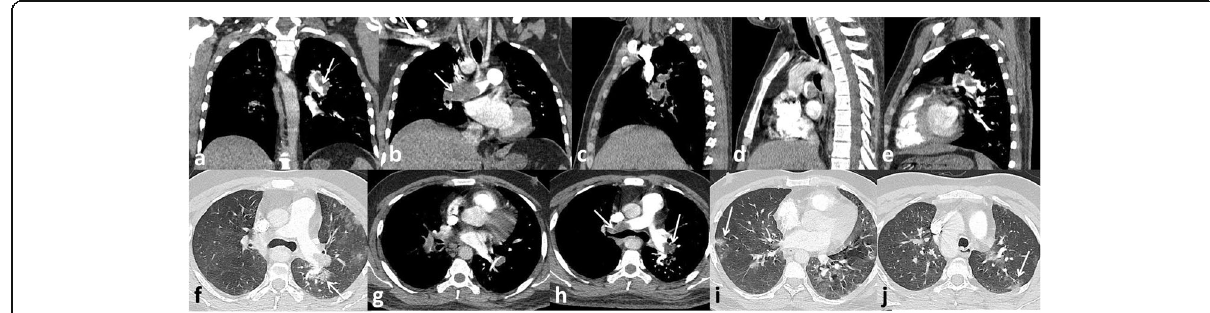
Fig. 3 Male patient, 32 years old. Pulmonary embolism at the main pulmonary arteries (white arrows a , b , and h ), ground-glass opacities of COVID-19 infection (white arrows f and i